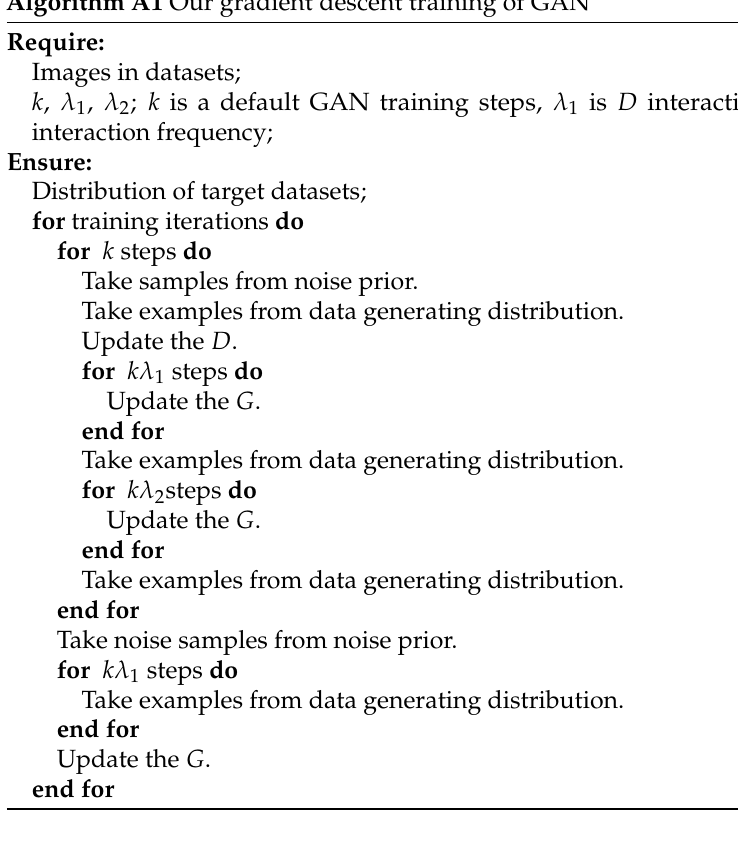
Algorithm A1 Our gradient descent training of GAN